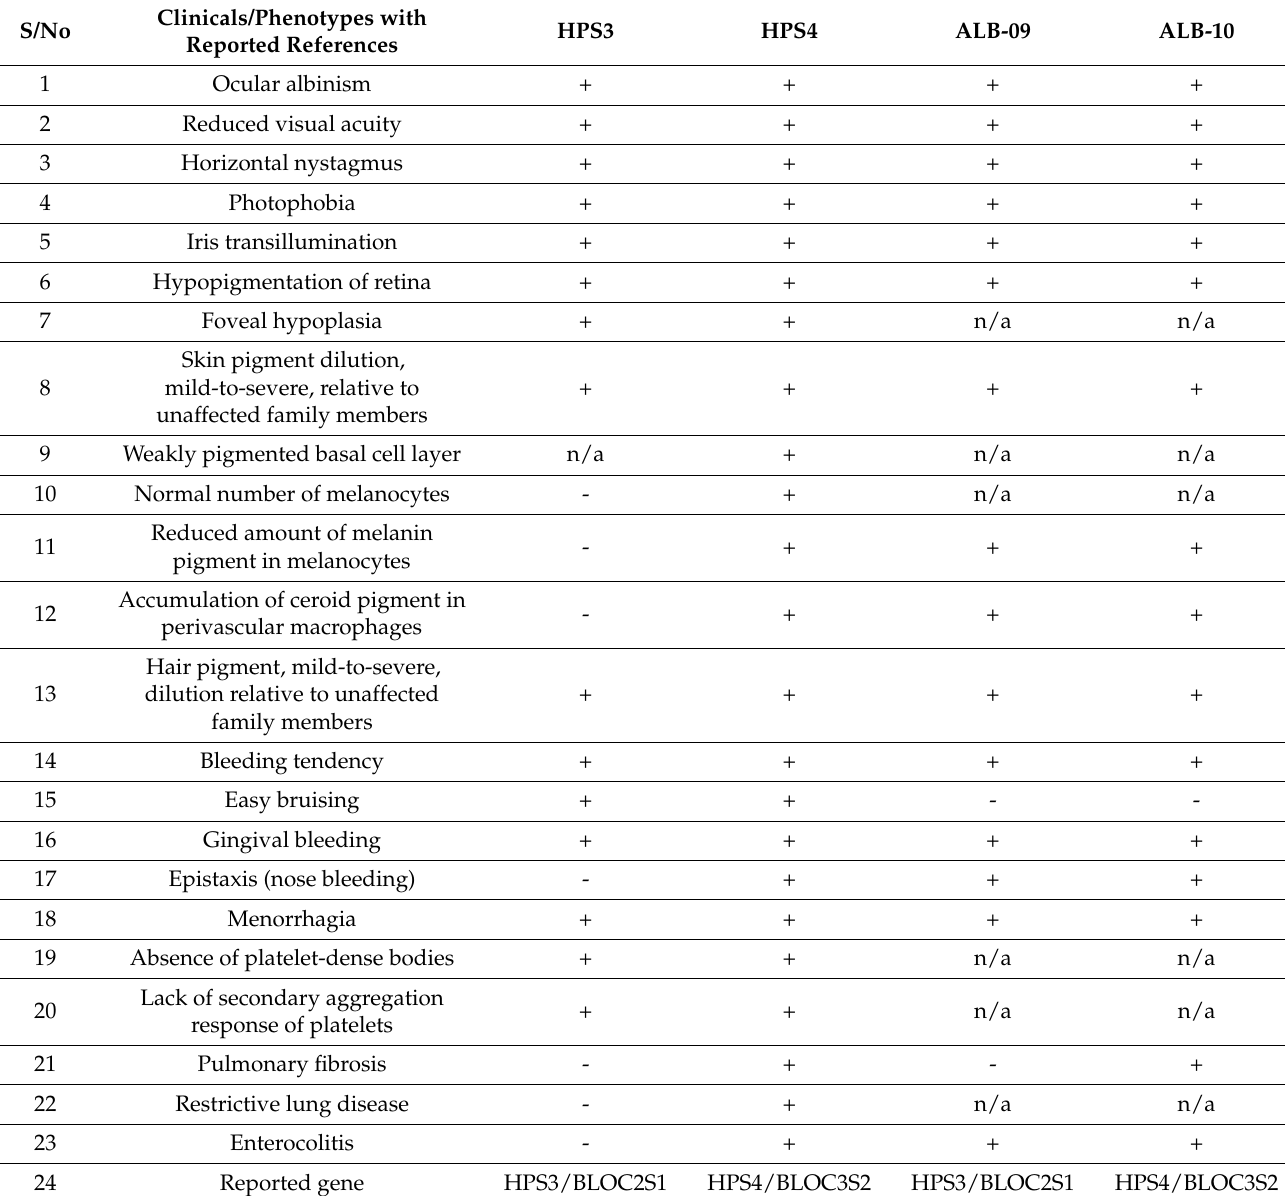
Table 2. Phenotypic comparison of HPS3 and HPS4 patients with the previously reported